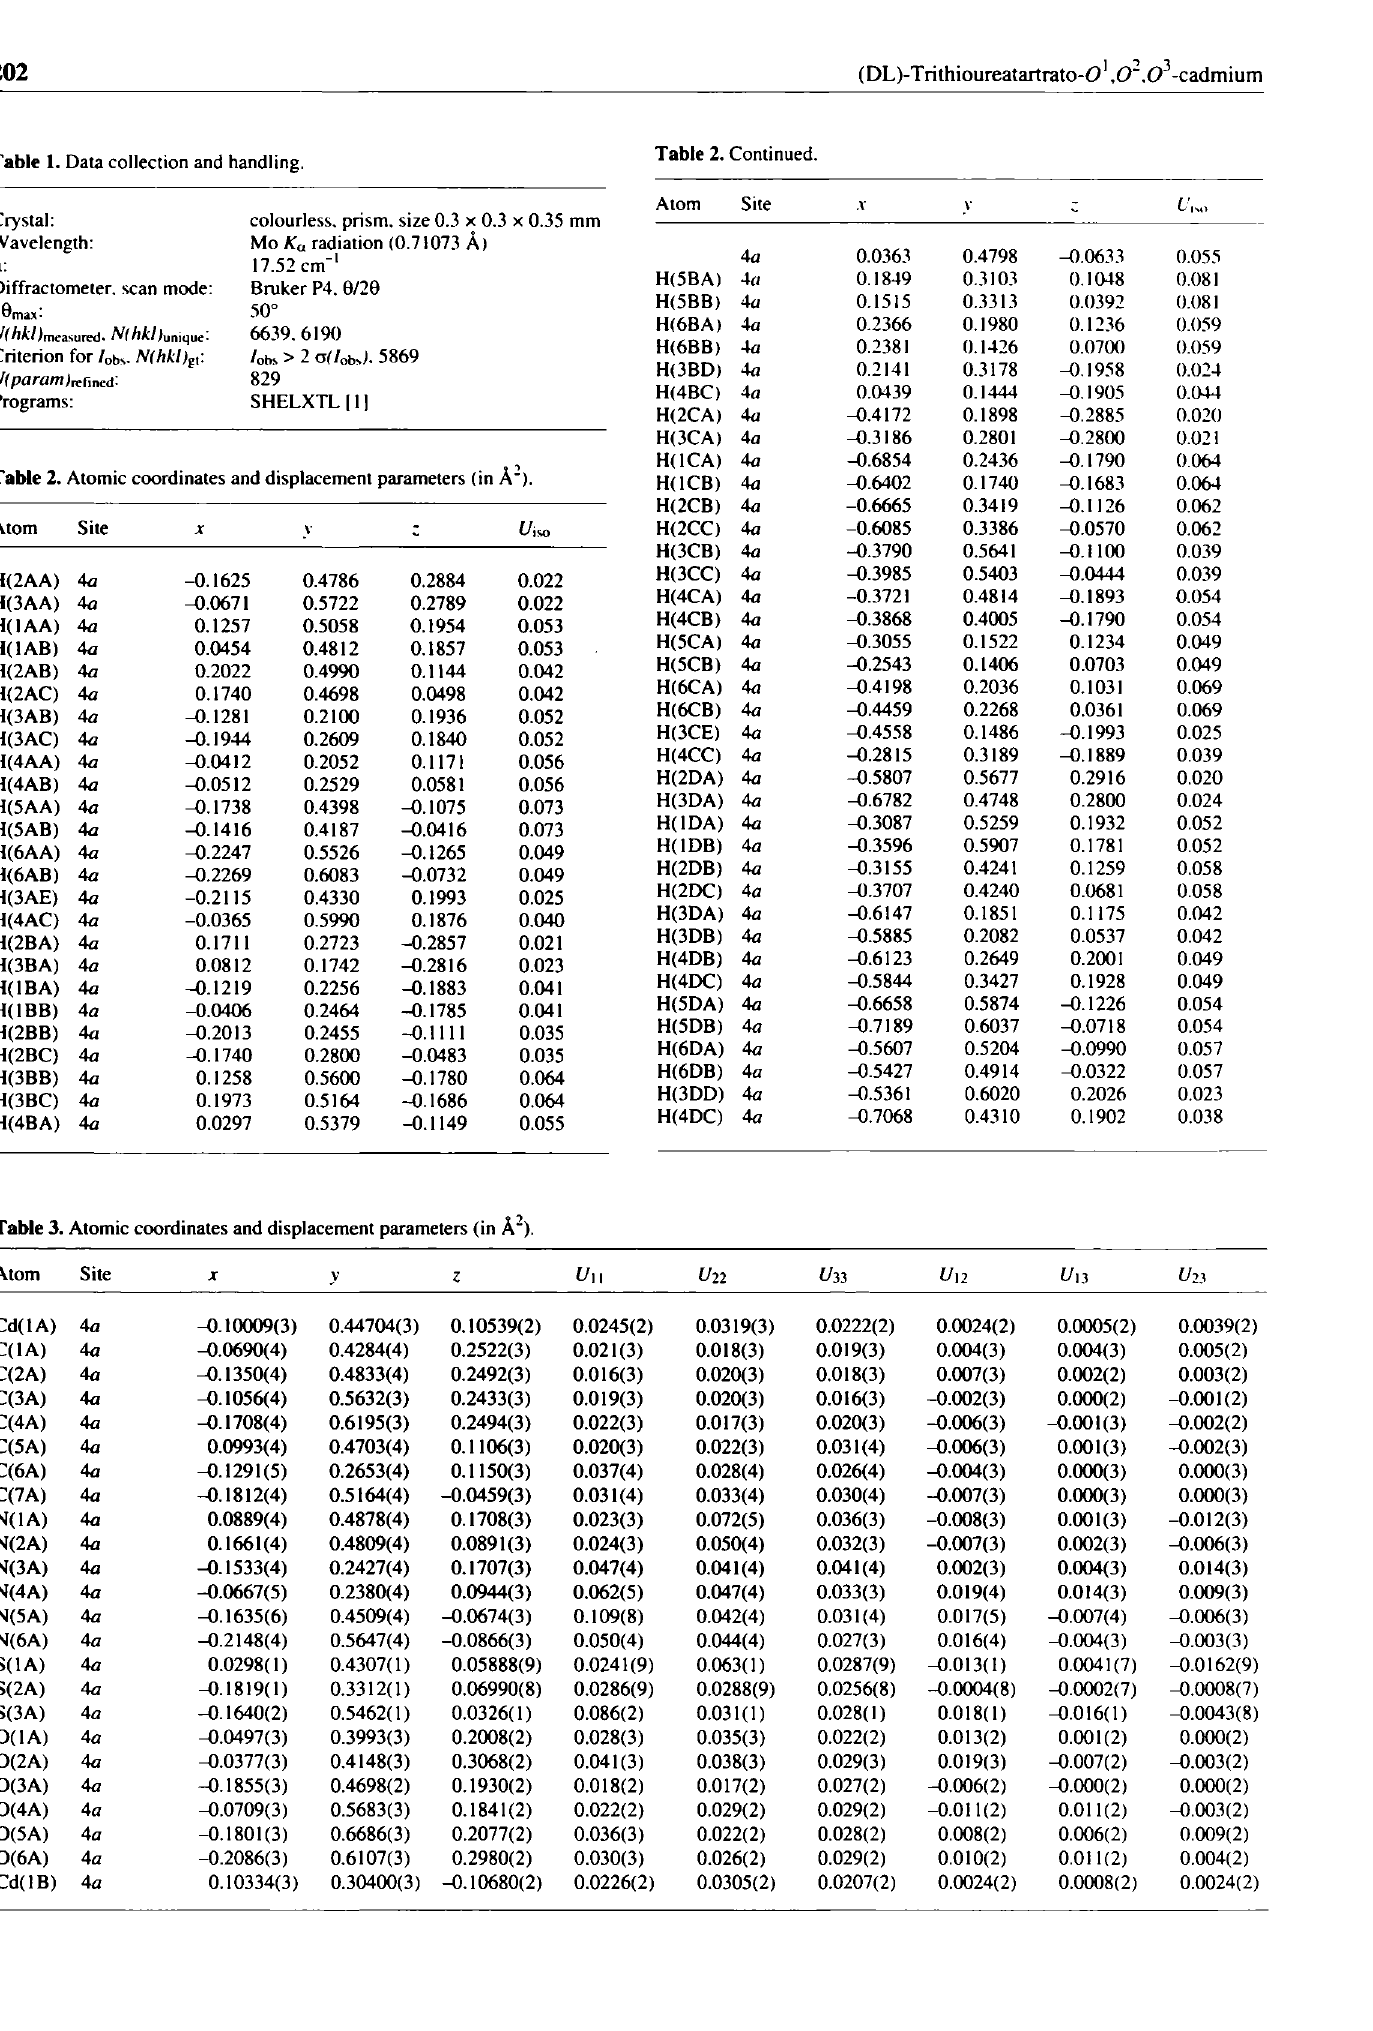
Table 2. Atomic coordinates and displacement parameters (in A~).